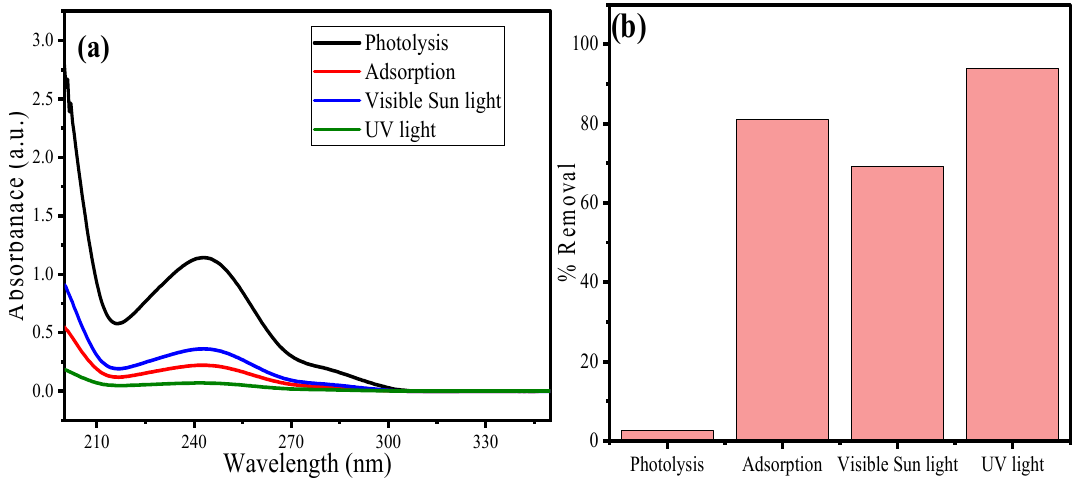
Figure 12. Effect of various reaction process and radiations on PCT degradation. ( a ) UV–Vis spectra, and ( b ) bar graph showing process vs. %PCT removal.